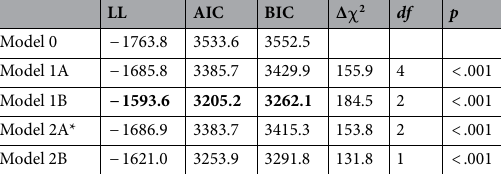
Table 5. Regression model fit indices. N, 208, obs, 4113; LL, log − likelihood; *, χ 2 compared to null model.